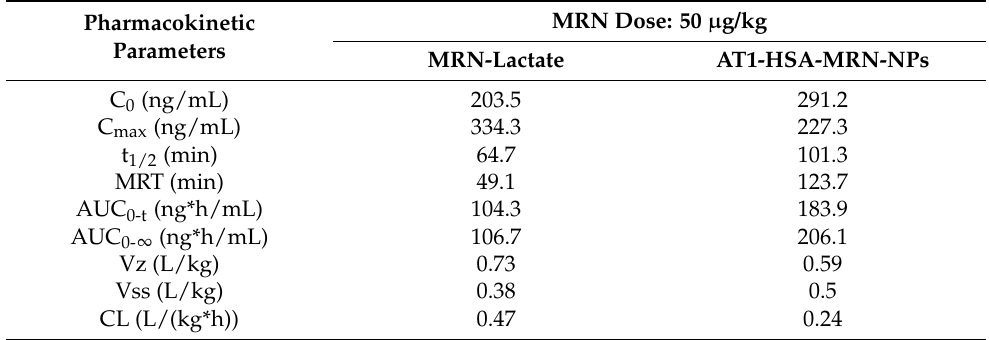
Table 3. Pharmacokinetic parameters of AT1-HSA-MRN-NPs and MRN Lactate at MRN dose 50 µ g/kg. C 0 : concentration at time 0; C max : maximum concentration; t 1/2 : half-life of plasma; MRT: mean residence time, AUC: area under the curve, Vz: apparent volume of distribution at elimination; Vss: apparent volume of distribution at steady state; CL: clearance.